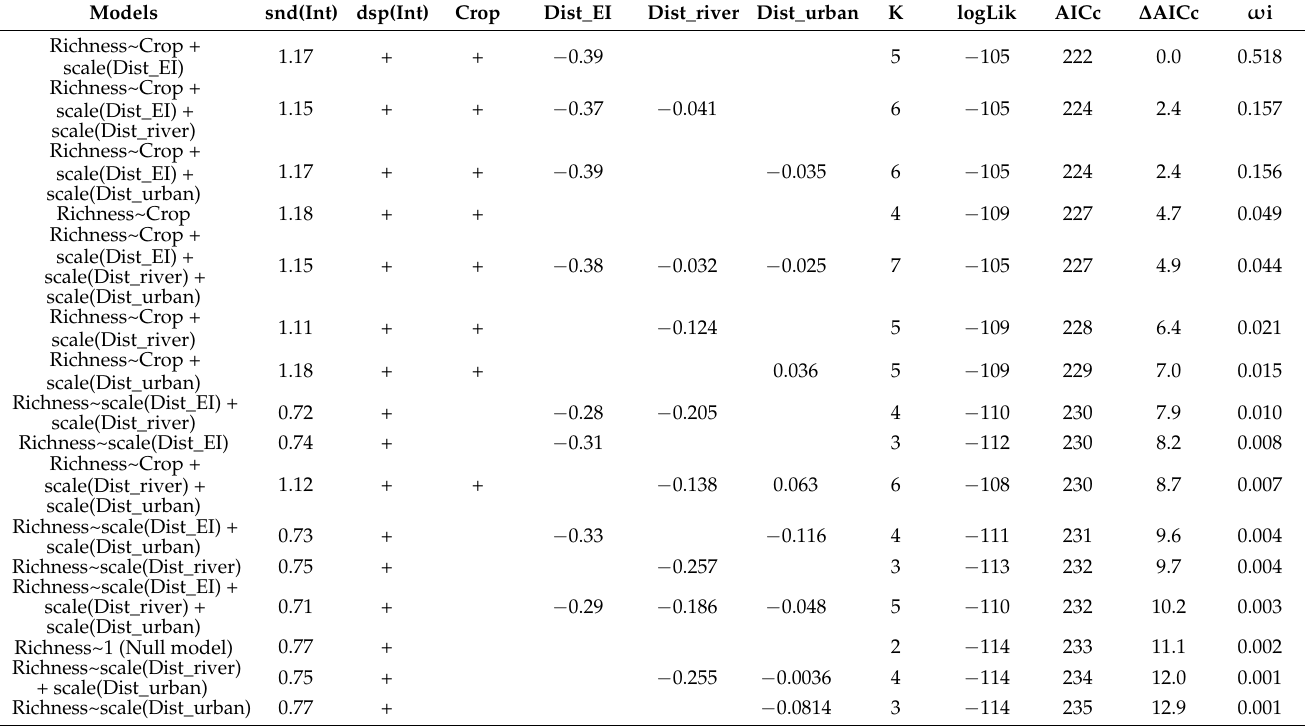
Table A1. Description of the GLMMs relating the effects of different predictors on the ant species richness in the agricultural matrix. Models are ranked in ascending order of AIC values and the number of parameters in the model (K), log-likelihood (logLik), AICc, ∆ AICc, and AICc weight ( ω i) are given for each model. The “+” signal means the inclusion of the nominal variables in the models.